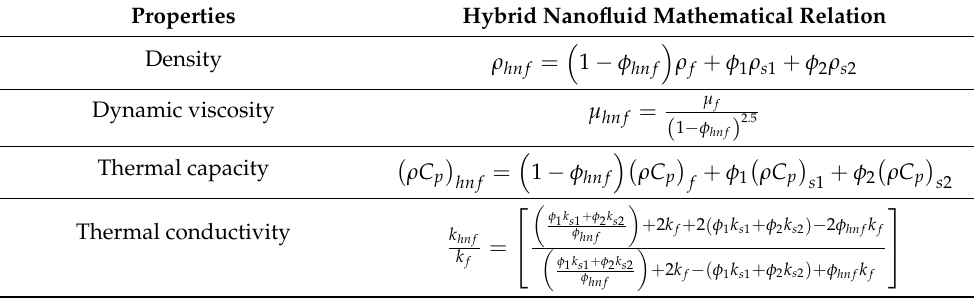
Table 1. The correlation properties of the Al 2 O 3 –Cu/H 2 O hybrid nanofluid can provide valuable insights into the behavior of the nanofluid. It is important to understand these properties to optimize the performance of the nanofluid in various applications. These correlations are adapted from Takabi and Salehi [32].